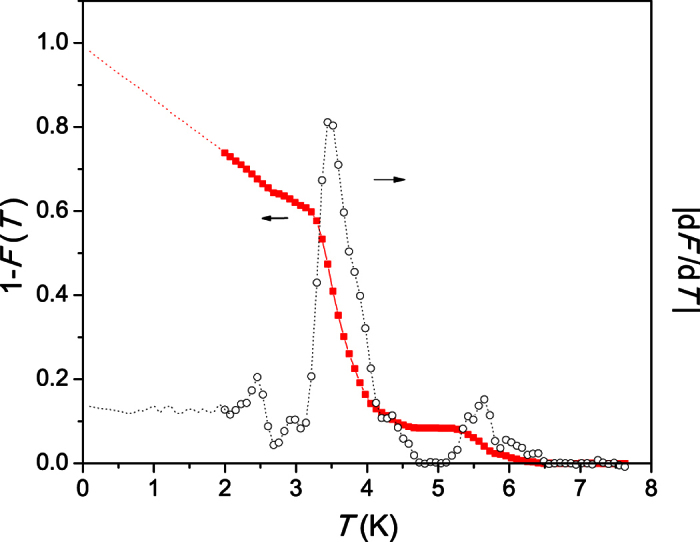
Superconducting volume fraction of a macroscopic sample of Sn nanowires 1 − F(T) and the corresponding Tc distribution dF/dT55.